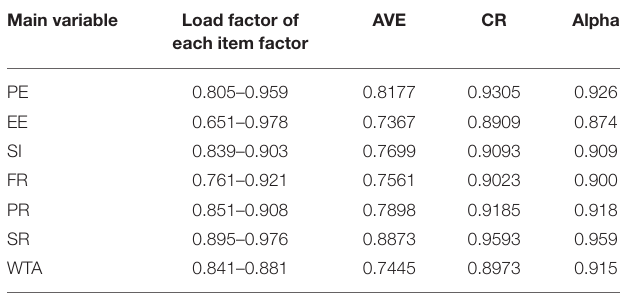
TABLE 4 | Model fitting results of influencing factors of college students’ acceptance intention after modification.